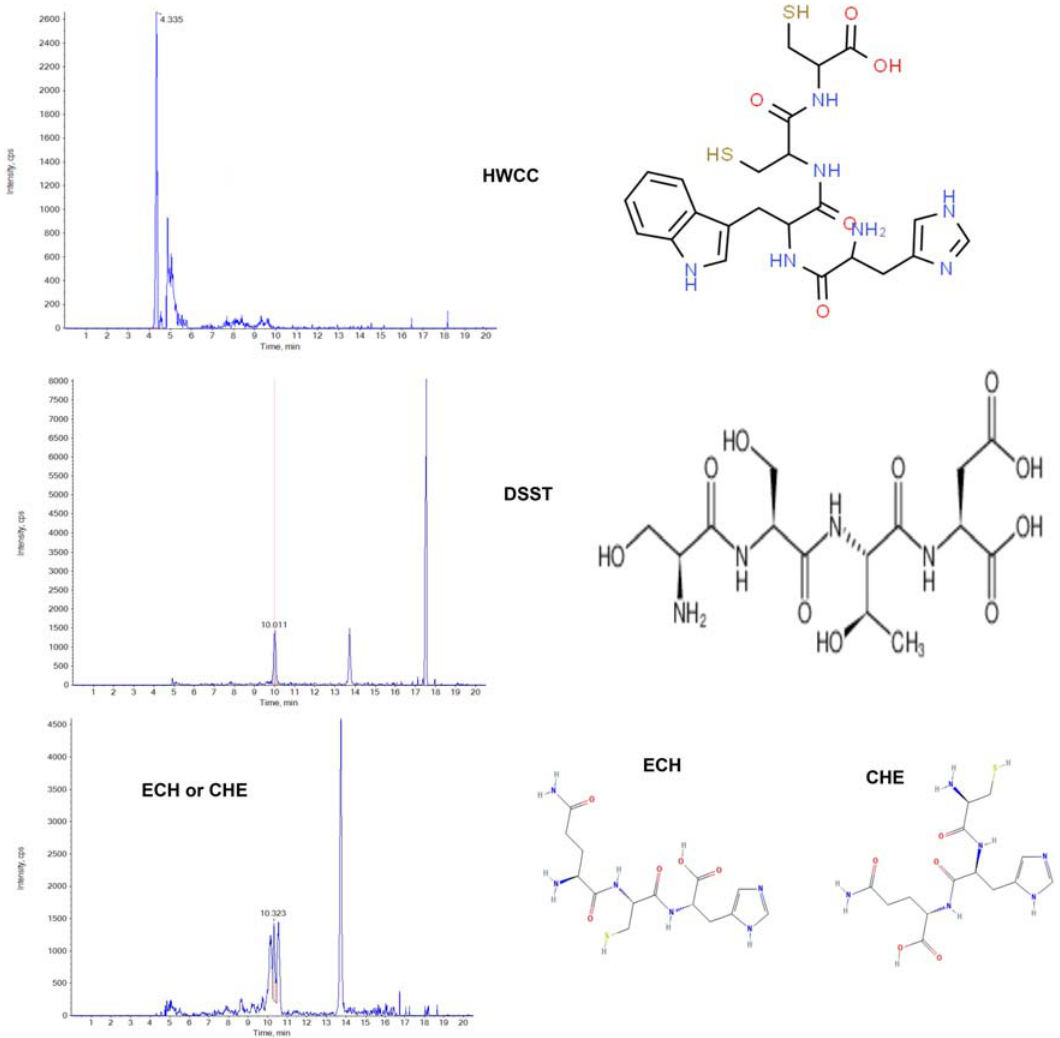
Figure 3: The LC - MS spectra of the short peptides in the Acacia tortilis honey sample. The three short peptides were HWCC, DSST, and ECH ( CHE ) . The molecular structure of the HWCC were retrieved from the ChemSpider, Molbase, and PubChem databases [ 16 – 19 ]